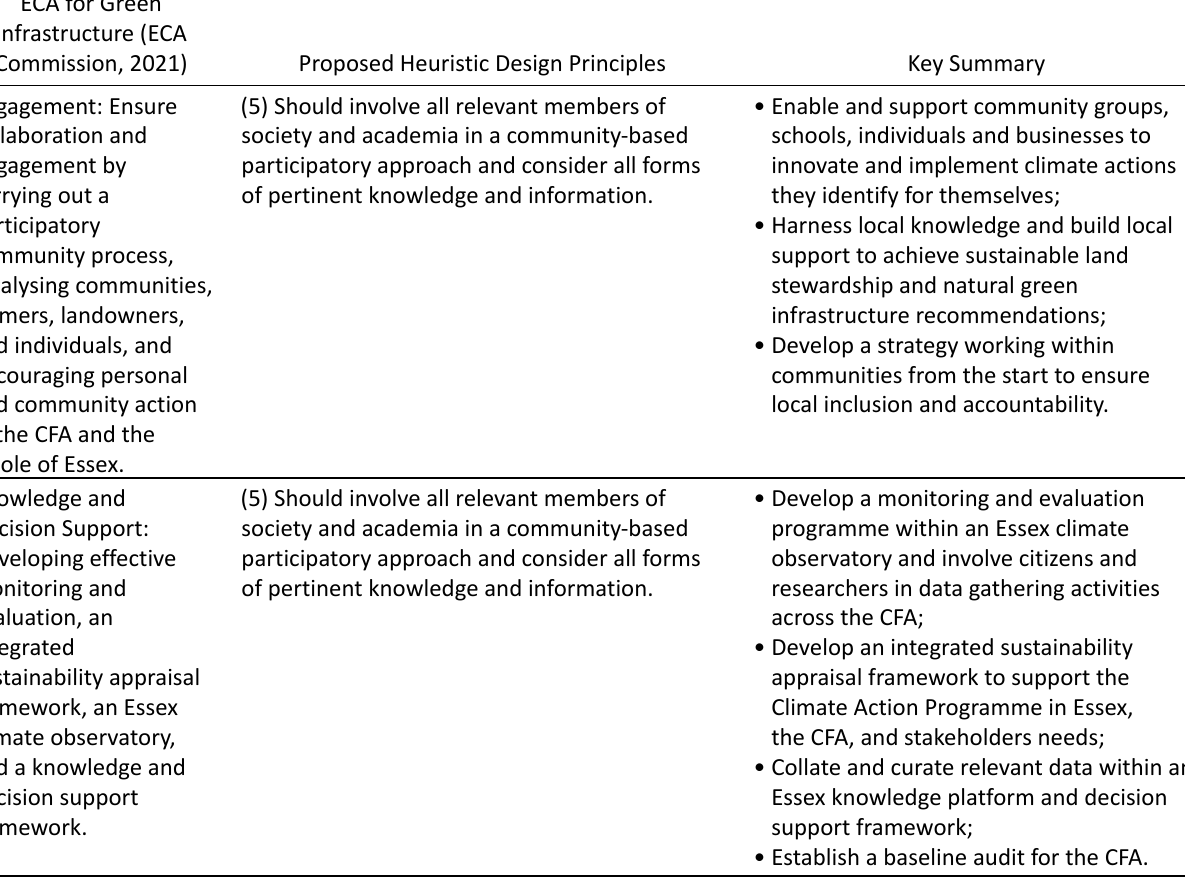
Table 1. (Cont.) ECA and heuristic design principle evaluation chart. This table shows the evaluation of ECA recommenda‐ tions through theoretical application of proposed heuristic design principles to the ECA recommendations. The key sum‐ mary demonstrates proposed action points for the ECA recommendations with an enhanced approach to ecosystem‐led planning and